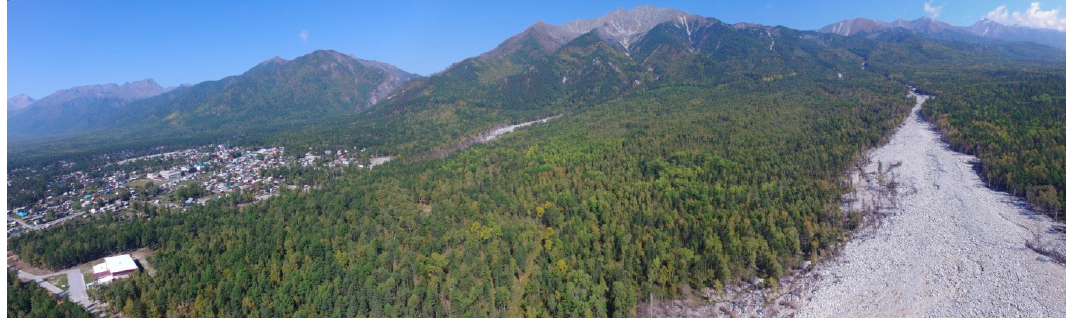
Figure 12. On the right is the frontal part of the mud-stone flow that passed along the river Vtoraya Shikhtolaika, on the left is the vil. Arshan (51°54 ′ 29.2887 ″ N, 102°26 ′ 50.9295 ″ E). The image was taken